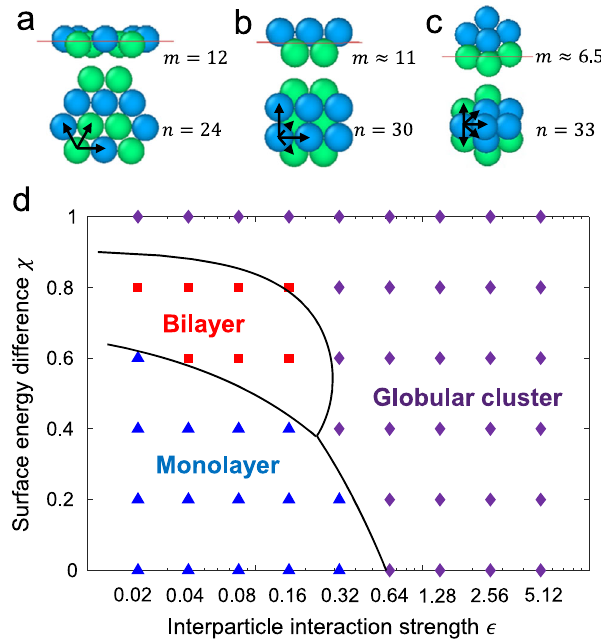
Fig. 3 | Analytical model for predicting phase coexistence boundaries. a – c Representativemonolayer( a ),bilayer( b ),andglobularcluster( c )phasesshowing effectivenumbersofNPsatequilibriumpositions m andnumberofNP-NPcontacts n in each structure. Arrows indicate contacts mediated by the chosen NP. d Phase boundaries predicted by the model are shown as solid black lines. The structural phases obtained through optimization (from Fig. 2a) are shown by